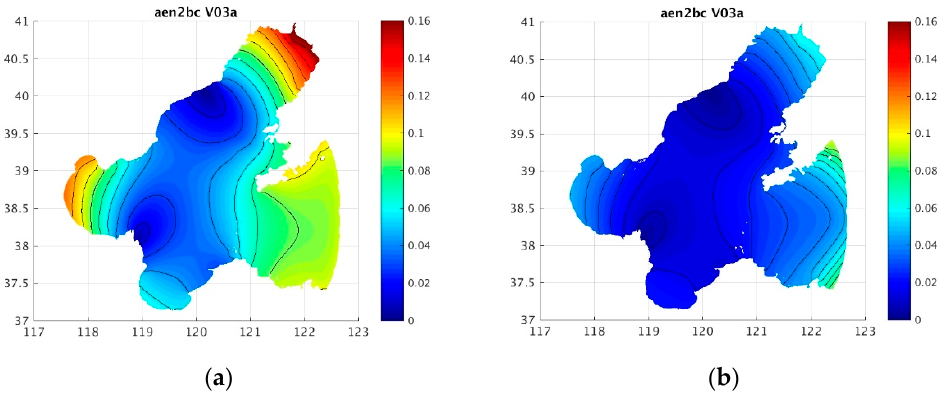
Figure 6. M 2 water level uncertainty field (m) from boundary condition only data assimilation. ( a ) prior error distribution of the model state variable, water level. ( b ) posterior error distribution.